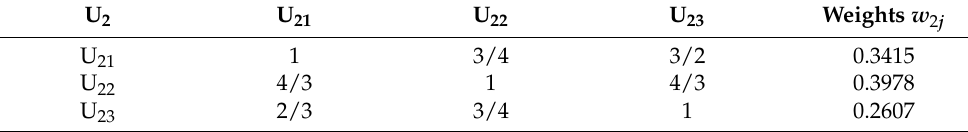
Table 7. Judgment matrix U 2 –U 2 j .